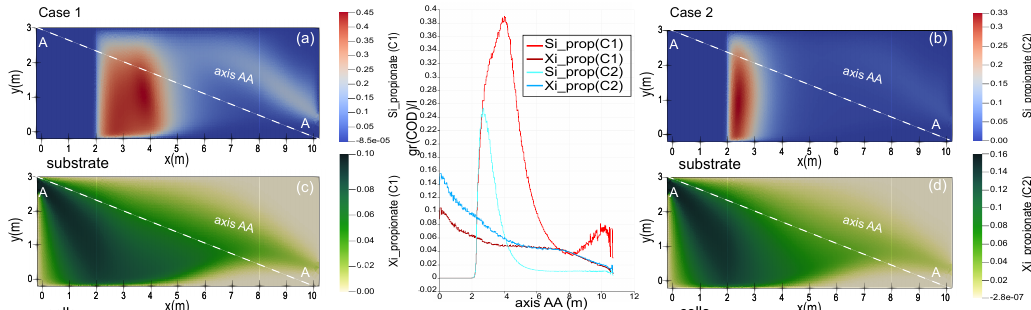
Figure 5. Performance of propionate, in steady state, for two different cases according to the initial concentration of propionic acetogenic bacteria and their graphic presentations along the axis AA. Case1; 110 (mg(COD) · L − 1 ) , Case2; 115 (mg(COD) · L − 1 ) .